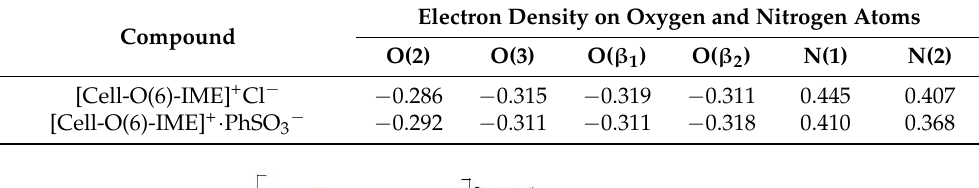
Table 9. The summary data electron density for analysed oxygen atoms of [Cell-O(6)-IME] + · PhSO 3 − . Electron Density on Oxygen and Nitrogen Atoms Compound